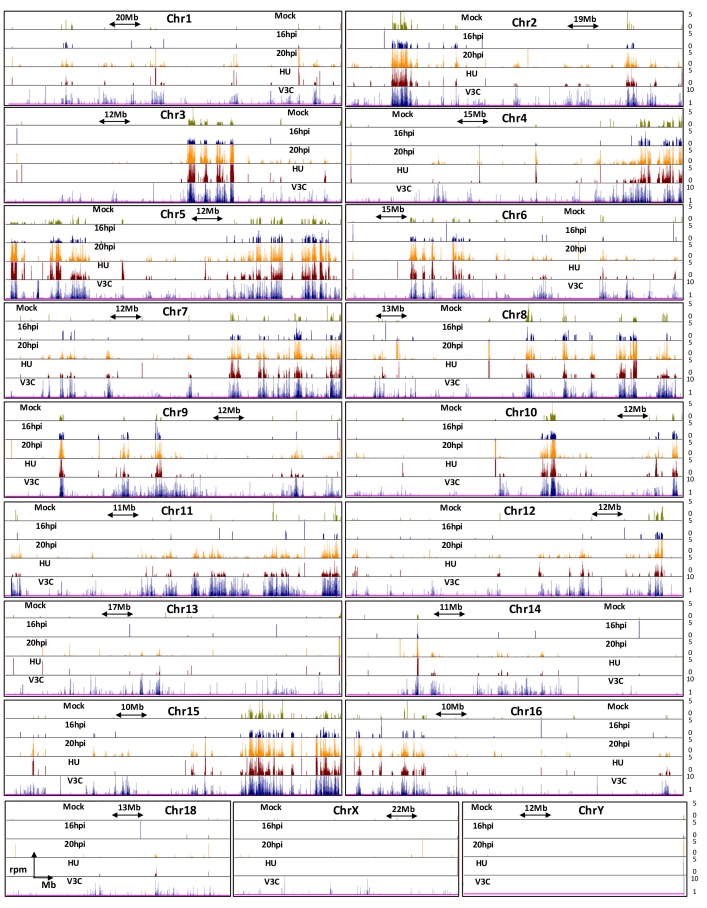
Genome browser snapshots of γ-H2AX occupancy over the entire mouse genome at different timepoints of MVM infection.Occupancy in mock infected and HU treated cells is also shown. Chromosomes 17 and 19 are presented in Figure 3A. γ-H2AX binding at the different timepoints and treatments are compared with MVM interaction sites at 16 hpi assayed by V3C-seq.